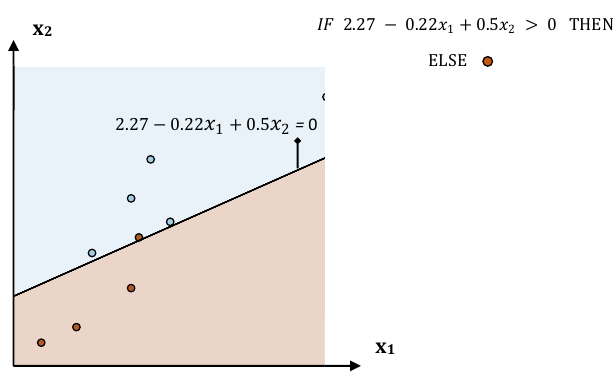
Figure 5. A visualization example presenting the decision function of a trained linear model.